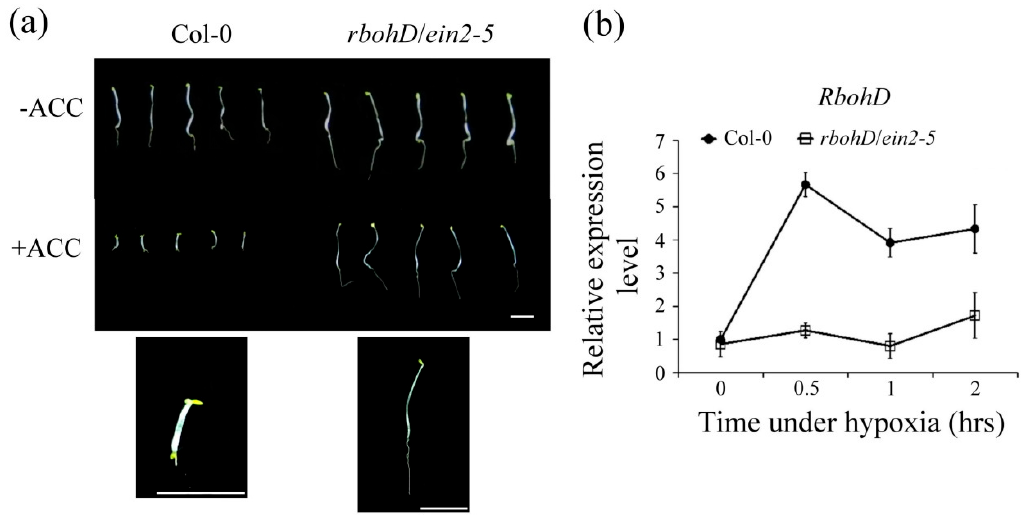
Figure 1 . Phenotypes of wild ‐ type Col ‐ 0 and rbohD / ein2 ‐ 5 double mutants in Arabidopsis . ( a ) The wild ‐ type (Col ‐ 0) and double mutant ( rbohD / ein2 ‐ 5 ) seeds were grown on 1/2 MS medium with 5 μ M ACC or without ACC for 4 d under dark conditions. Bar = 0.5 cm. ( b ) Quantitative RT ‐ PCR analyses of transcript levels of RbohD in Arabidopsis Col ‐ 0 and rbohD / ein2 ‐ 5 double mutants in response to hypoxic stress for 0, 0.5, 1, and 2 h. Total RNAs were isolated from roots of 14 ‐ day ‐ old seedlings after hypoxia treatment at indicated times and levels of RbohD mRNA were determined. Relative transcript amounts were calculated and normalized to Actin mRNA levels. Values represent means ± SD from five biologically independent experiments.